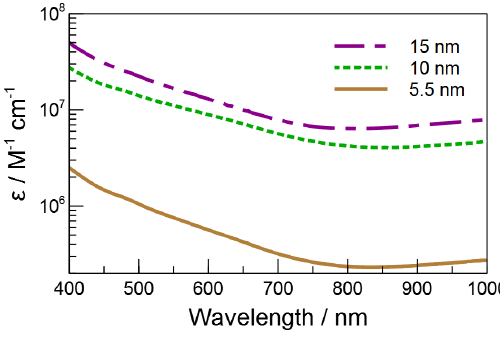
Figure 4. Extinction spectra of the three sizes of MNP.